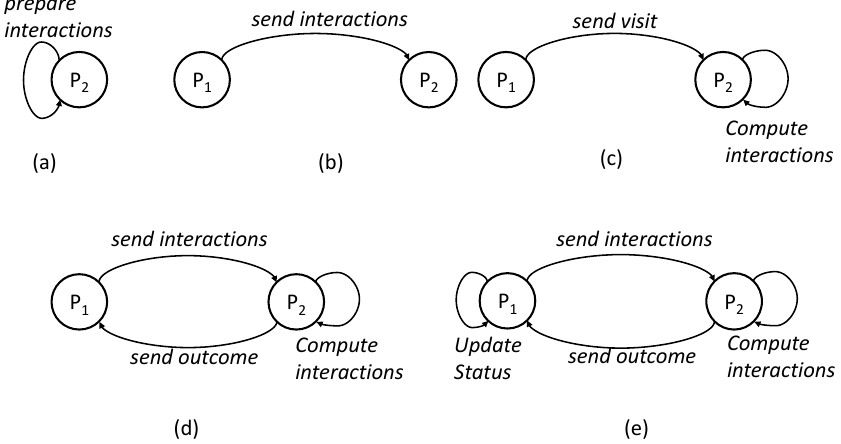
Figure 5. Five steps of a simulation day. ( a ) A person compute interactions for the day. ( b ) A person sends interactions to other interacting persons. ( c ) Person performs interaction between received requests. ( d ) Person send outcomes to sending person if infection happens ( e ) Persons and locations updates their